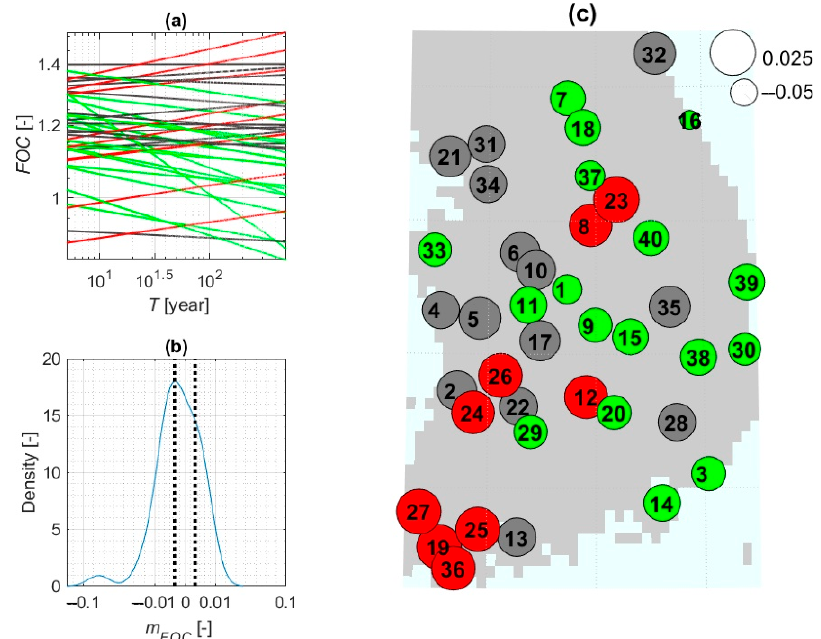
Figure 7. Future change ( FOC ) of rainfall frequency estimates over return periods ( T ) for 1-h duration for future END period of RCP 8.5. Subplot ( a ) illustrates the FOC of rainfall frequency estimates over return periods for 40 locations. The grey lines have relatively smaller slope values that fall within half the standard deviation with respect to zero—the dark dash lines in subplot ( b ). The red (green) lines have greater (smaller) slopes than the half standard deviation. Subplot ( b ) represents a kernel distribution of the slopes of FOC ( m FOC ) for 40 locations in subplot ( a ). Subplot ( c ) illustrates the spatial distribution of the slope, the colored circles correspond to the colored lines in subplot ( a ). The number near white circles is the legend to show the relative magnitude of slopes.